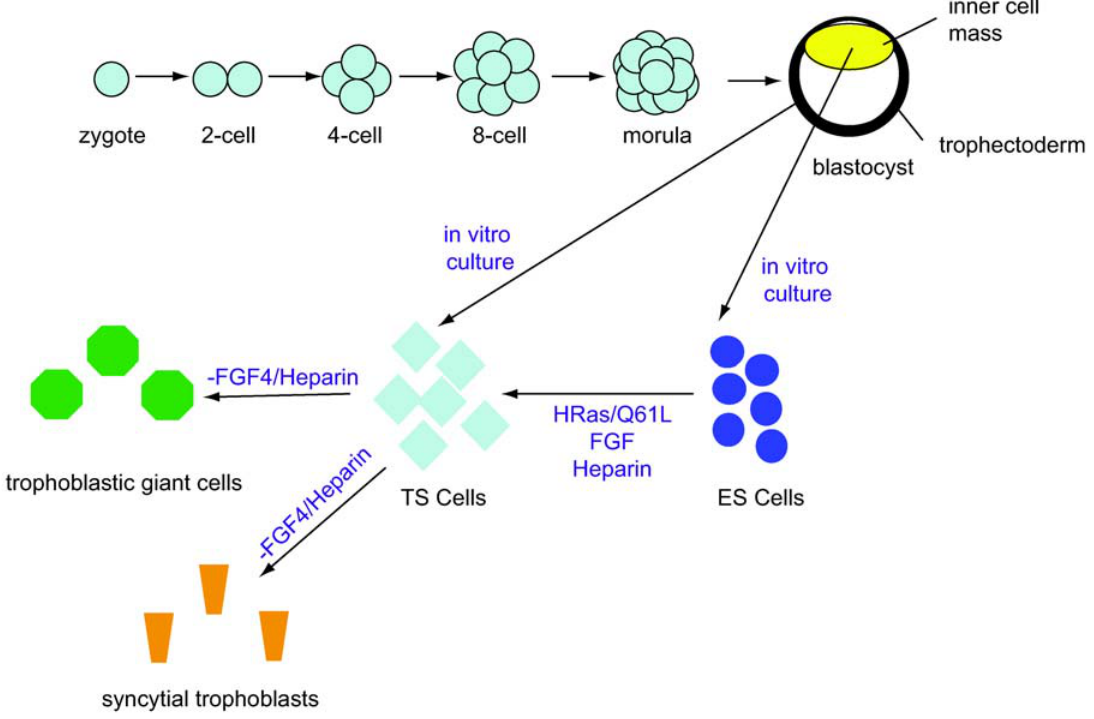
Figure 1. A schematic of trophectoderm specification invitro and in vivo . In the developing mouse embryo, the trophectoderm is segregated from the inner cell mass between the morula and blastocyst stages of development. ESCs, derived from the inner cell mass, can be induced to differentiate into trophectodermal stem cells (ES-TS cells) by expression of HRas/Q61L and appropriate culture conditions. In the absence of FGF4, ES-TS and TS cells differentiate into trophectodermal cell types, such as trophoblastic giant cells and syncytial trophoblasts.